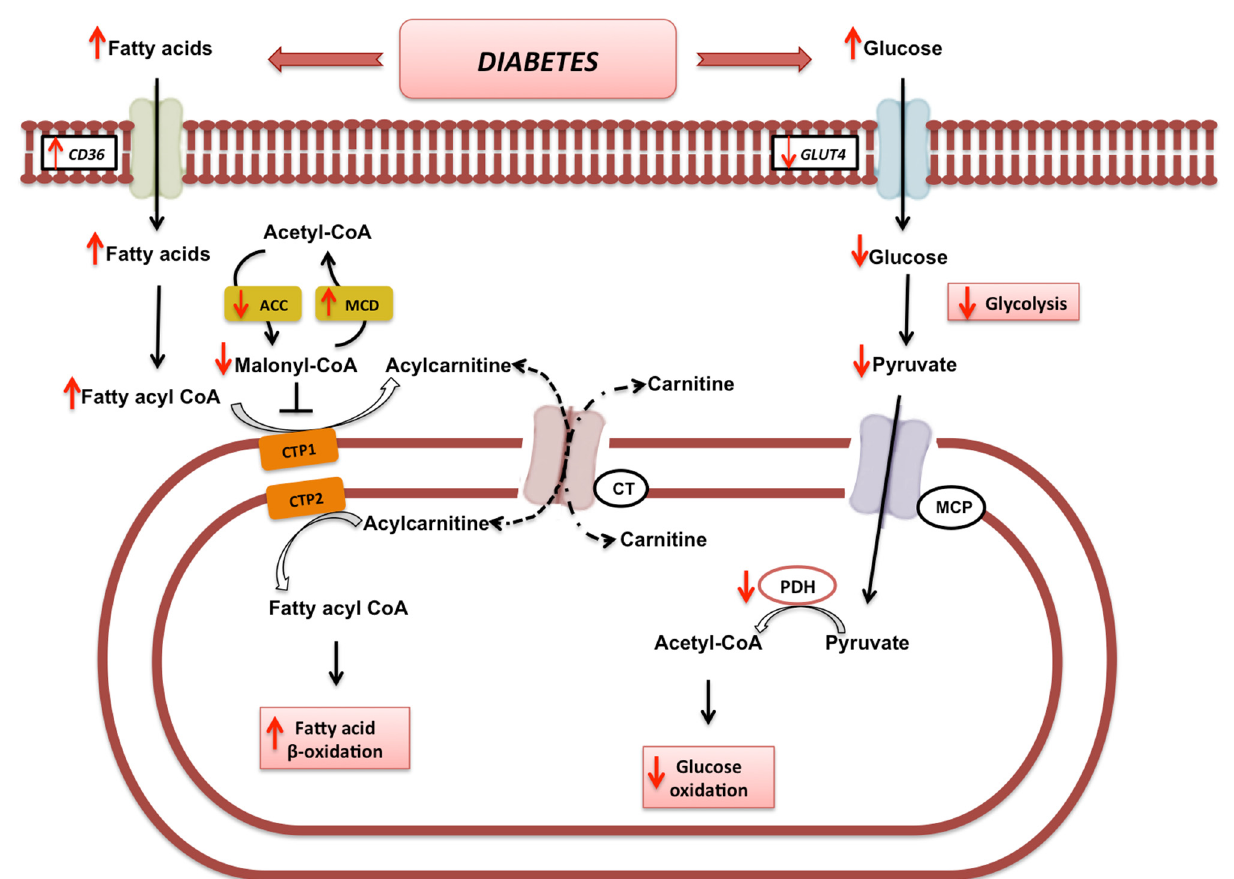
Figure 1. Metabolic alterations in diabetic patients . At the molecular level, insulin resistance causes an increase in both plasma glucose and serum insulin levels, which lead to a reduction in glucose transporter type 4 (GLUT4), and a decrease in glucose uptake. These events lead to a reduction in the glycolysis pathway and glucose oxidation caused by the downregulation of the pyruvate dehydrogenase complex (PDH). The hyperglycaemia is associated with the concomitant increase in hematic fatty acid concentration and the consequent upregulation of fatty acids uptake and oxidation due to the decreased levels of malonyl CoA and the consequent activation of carnitine palmitoyltransferase 1 (CPT1). CD36—cluster of differentiation 36; ACC—Acetyl-CoA carboxylase;